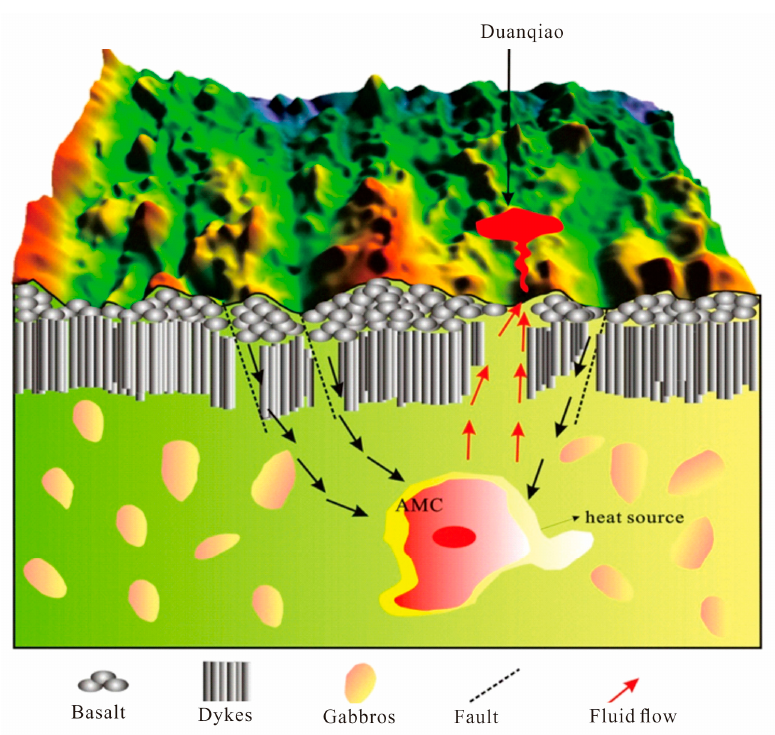
Figure 2. A metallogenic model of Duanqiao hydrothermal region in SWIR [43].